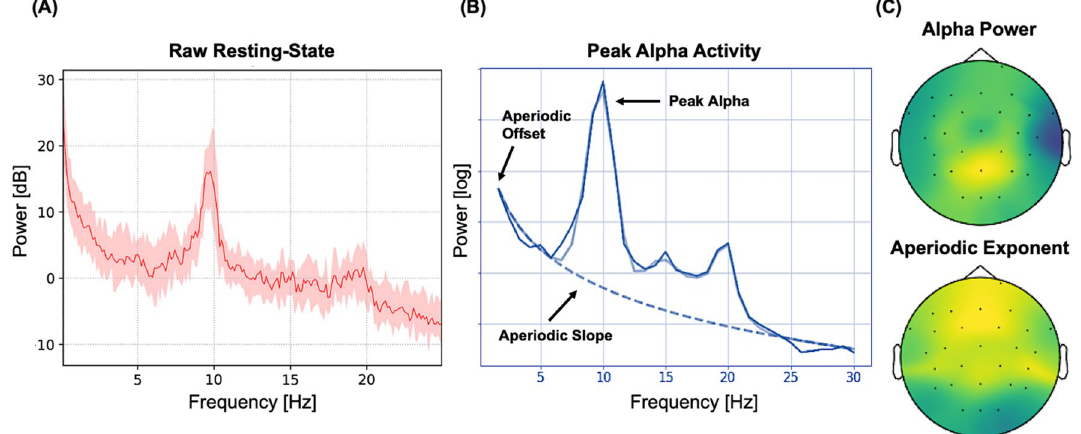
Figure 9. Exemplar power spectral density (PSD) estimates of fractal (aperiodic 1/ƒ) and oscillatory activity from a single participant. ( A ) PSD plot from two minutes of an eyes-closed resting state period. Power (dB) is presented on the y-axis, while frequency (Hz) is on the x-axis. The solid line represents the mean power across all channels, while the shaded area represents the standard error of the mean. ( B ) Separation of oscillatory (dark solid blue and solid light blue lines) and aperiodic (dashed blue line) components 31 . Power (log) is on the y-axis, while frequency (Hz) is on the x-axis. Note the clear alpha oscillatory peak at approximately 10 Hz. ( C ) Top: topographical distribution of alpha power within the peak alpha range as shown in ( B ). Bottom: topographical distribution of the aperiodic exponent. Warmer colours denote greater alpha power and a higher aperiodic exponent (i.e., steeper